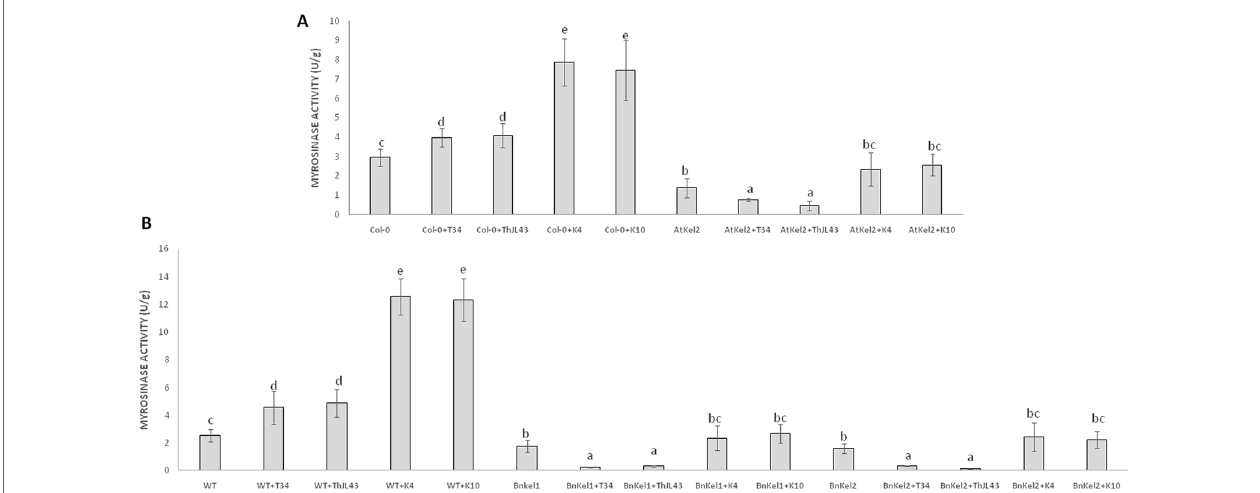
FIgURE 8 | Myrosinase activity (U/g of protein) in roots of A. thaliana wild type (Col-0) and transgenic line (AtKel2) plants (a) and rapeseed commercial variety (WT) and transgenic lines (BnKel1 and BnKel2) plants (B) , after inoculation with the control strain (+T34), the transformation control (+ThJL43), and the transformants with the silenced Thkel1 gene (+K4 and +K10) of T. harzianum . Data are the mean of three biological replicates for each condition with the corresponding standard deviation, and for each biological replicate and condition, roots from five plants were used. One-way analysis of variance (ANOVA) was performed, followed by the Tukey’s test. Different letters represent significant differences ( P < 0.05) between plants with and without fungal inoculation.